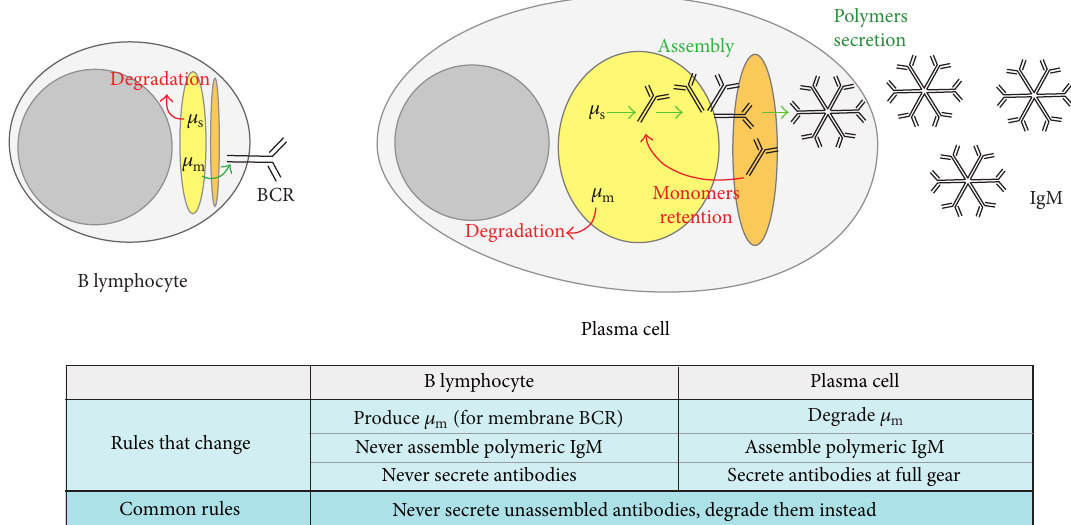
Figure 2: Rules for IgM processing in B lymphocytes and plasma cells.B lymphocytes do not produce secretory antibodies. In B lymphocytes HC ( 𝜇 ) is synthesized in the ER; it is assembled in the early secretory pathway (in yellow) and then proceeds through the Golgi Ig- 𝜇 m m (orange) to be exposed on the plasma membrane as part of the BCR; Ig- 𝜇 Conversely, plasma cells are hardworking antibodies factories; they degrade 𝜇 them in bulk. Incompletely assembled IgM subunits are retained in the secretory pathway for another chance of being inserted into a polymer or to be finally